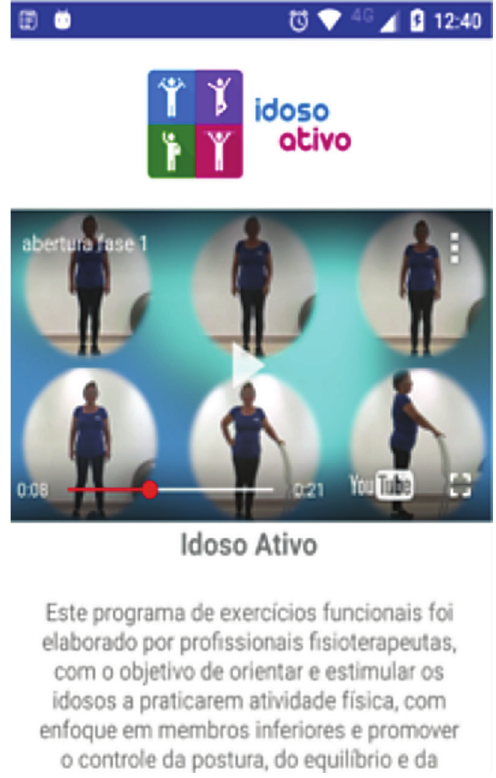
Figure 4 - Preview with presentation of each